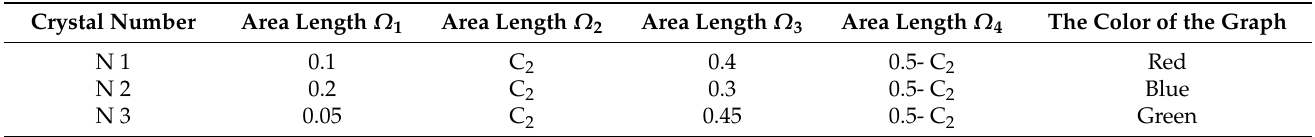
Table 4. Parametric fragmentation of the elements of the unit